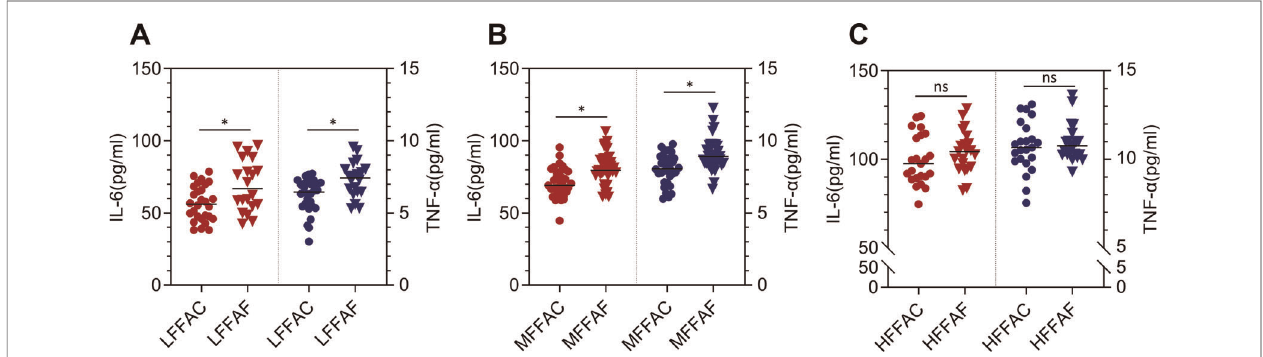
FIGURE 2 | Plasma IL-6 and TNF- α levels on postoperative Day 1. ( A ) Comparison of IL-6 and TNF- α levels between LFFAC and LFFAF. ( B ) Comparison of IL-6 and TNF- α between MFFAC and MFFAF. ( C ) Comparison of IL-6 and TNF- α levels between HFFAC and HFFAF. * represents a signi fi cant difference ( p <0.05).